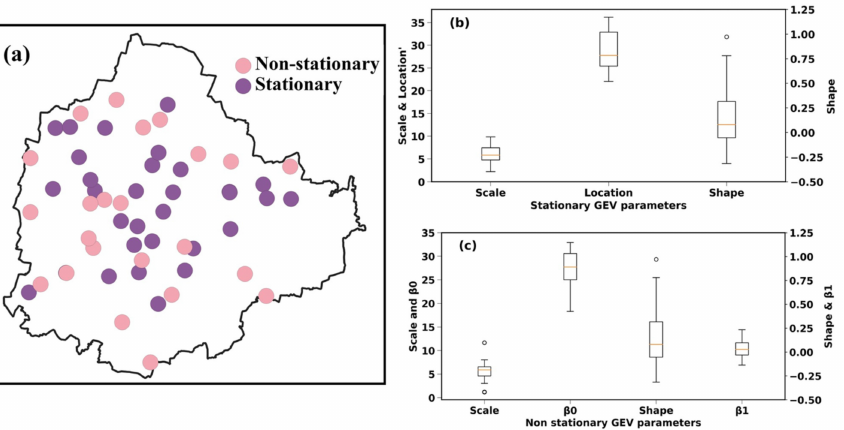
Figure 5. ( a ) KSNDMC stations that experienced non-stationarity in their annual maximum rain- fall series following an ADF test. ( b , c ) The parameters of the stationary and non-stationary GEV models,